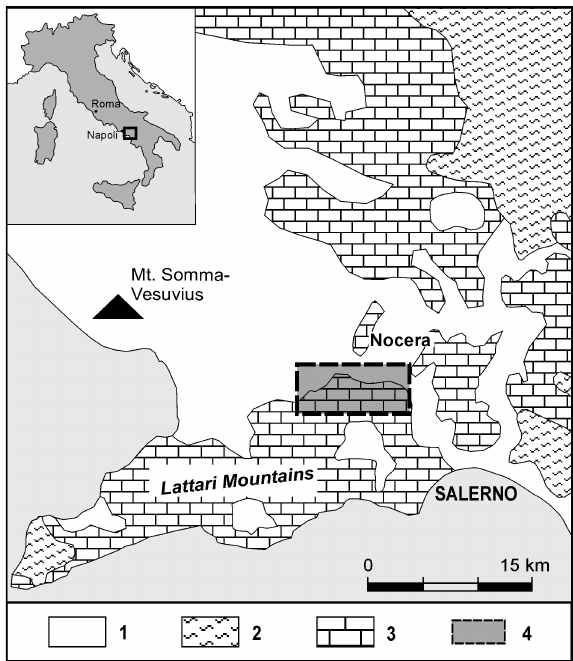
Fig. 1. Location of the study area. (1) Epiclastic and pyroclastic deposits (thickness > 10m), Holocene; (2) Flysch and silicoclastic deposits, Mesozoic – Tertiary; (3) Carbonate rocks with thin vol- canoclastic deposits (thickness < 10m), Mesozoic; (4) Study area.